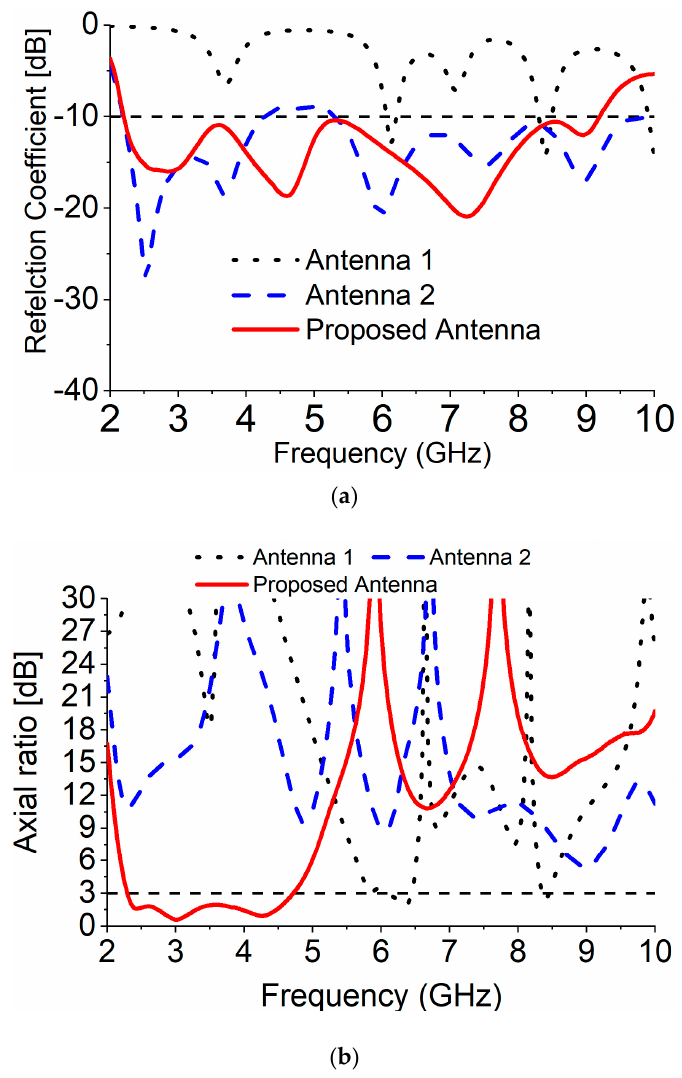
Figure 3. Effects of antenna evaluation: ( a ) reflection coefficient (S 11 ), ( b ) AR.